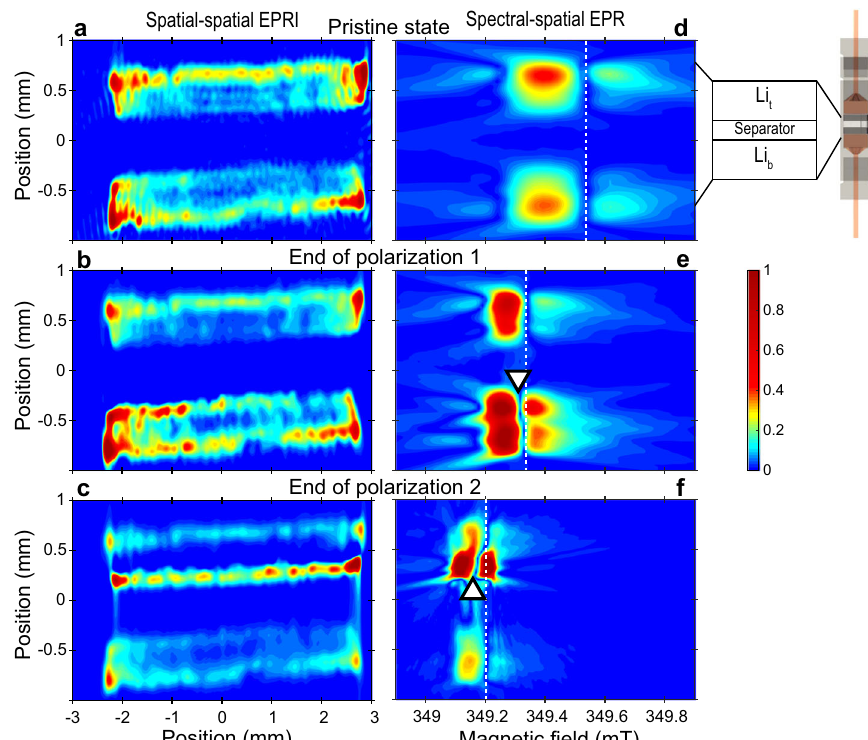
Fig. 3 In situ X-band EPR images. a – c Spatial-spatial images and d – f spectral-spatial images of the cell in the pristine state, at the end of polarization 1 and at the end of polarization 2, respectively. The spectral-spatial images display the absolute value of the EPR line ∣ d χ ” / dH ∣ . The vertical dashed line indicates the resonance fi eld of the bulk Li signal and the white triangle the resonance fi eld of the sharper component (guides to the eye). The fi eld of the vertical dashed line shifts between spectral-spatial EPR images due to a change of the microwave frequency. The color bar indicates the color code for the peak to peak amplitudes, identical for all plots. The illustration of the EPR cell has been created by Charles-Emmanuel Dutoit using an open-source 3D computer graphics software (Blender